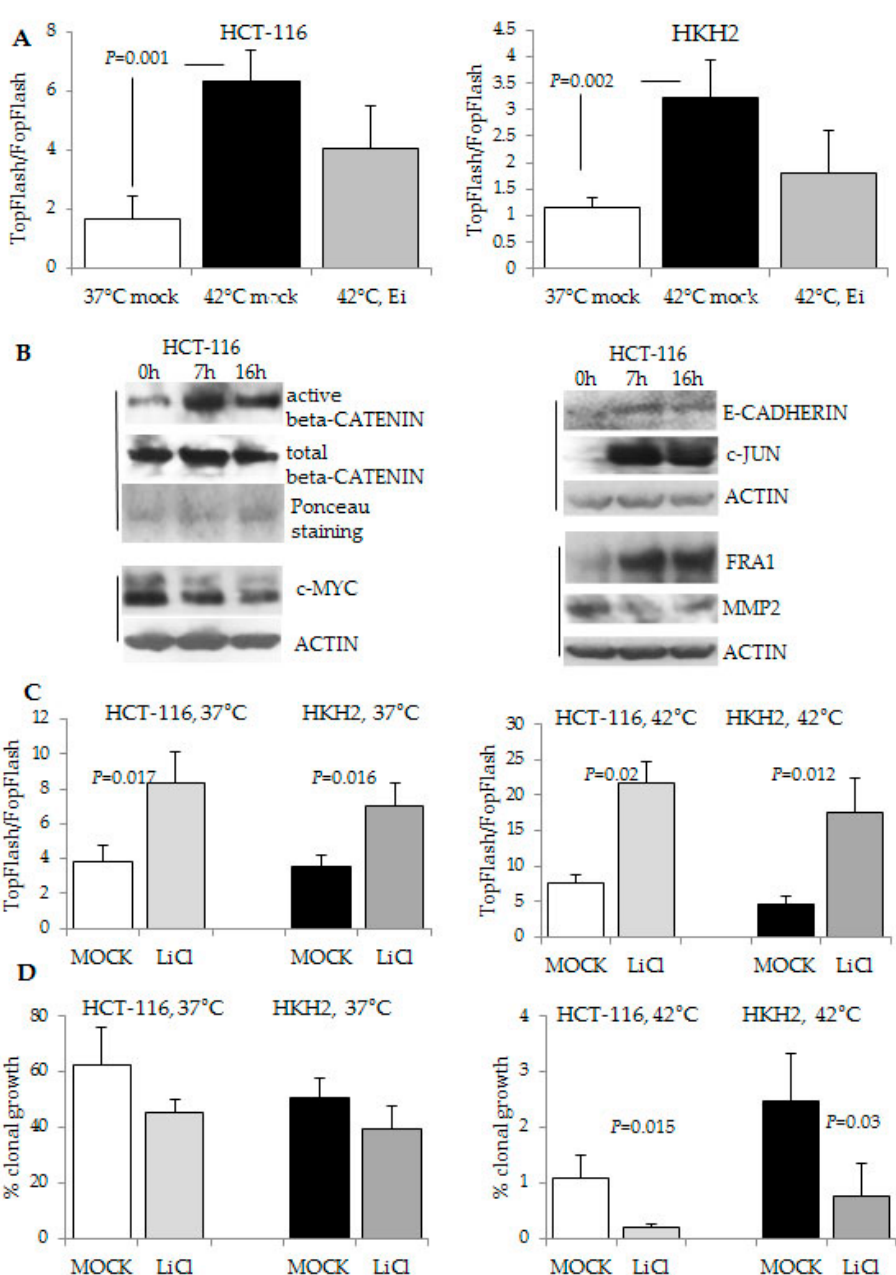
Figure 5. Modulation of WNT/beta ‐ catenin activity impacts the response of CRC cells to hyperthermia. ( A , C ) WNT/beta ‐ catenin transcriptional activity was measured with the luciferase reporter pair TOP ‐ Flash and FOP ‐ Flash. Treatments (16 h) with lithium chloride were performed at 20 mM, or with AZD6244 (Ei) at 0.5 μ M. The standard deviations are based upon three experiments with duplicate samples per treatment and condition (temperature) were performed; ( B ) Representative Western blot analyses with nuclear or total cell lysates of HCT ‐ 116 cells exposed to 42 °C for 0, 7, or 16 h. Active and total beta ‐ catenin were detected in nuclear lysates and equal loading was ascertained by Ponceau staining. Additional markers of WNT/beta ‐ catenin activity were analyzed with total cell lysates. Vertical lines indicate same Western blot analyses; ( D ) Clonal growth assays as described in Figure 1 were performed with 20 mM lithium chloride. Standard deviation was calculated based upon three independent experiments with triplicate samples.